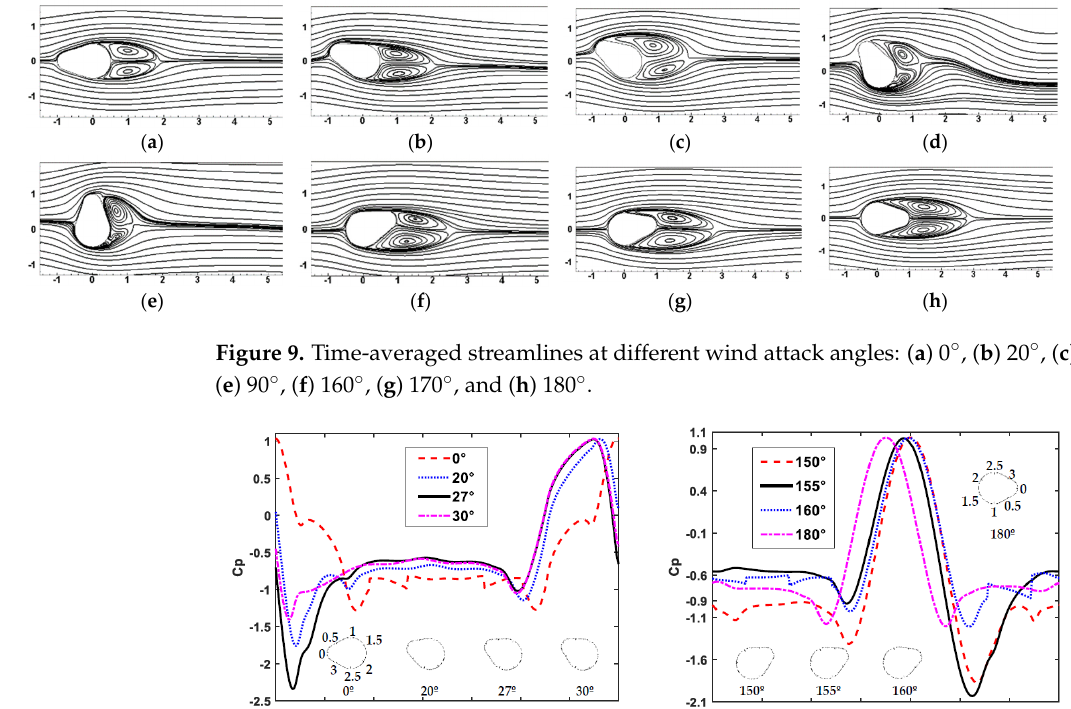
α = 0°, 10°, 20°, 30°, α = 170°, 176°, 178°,